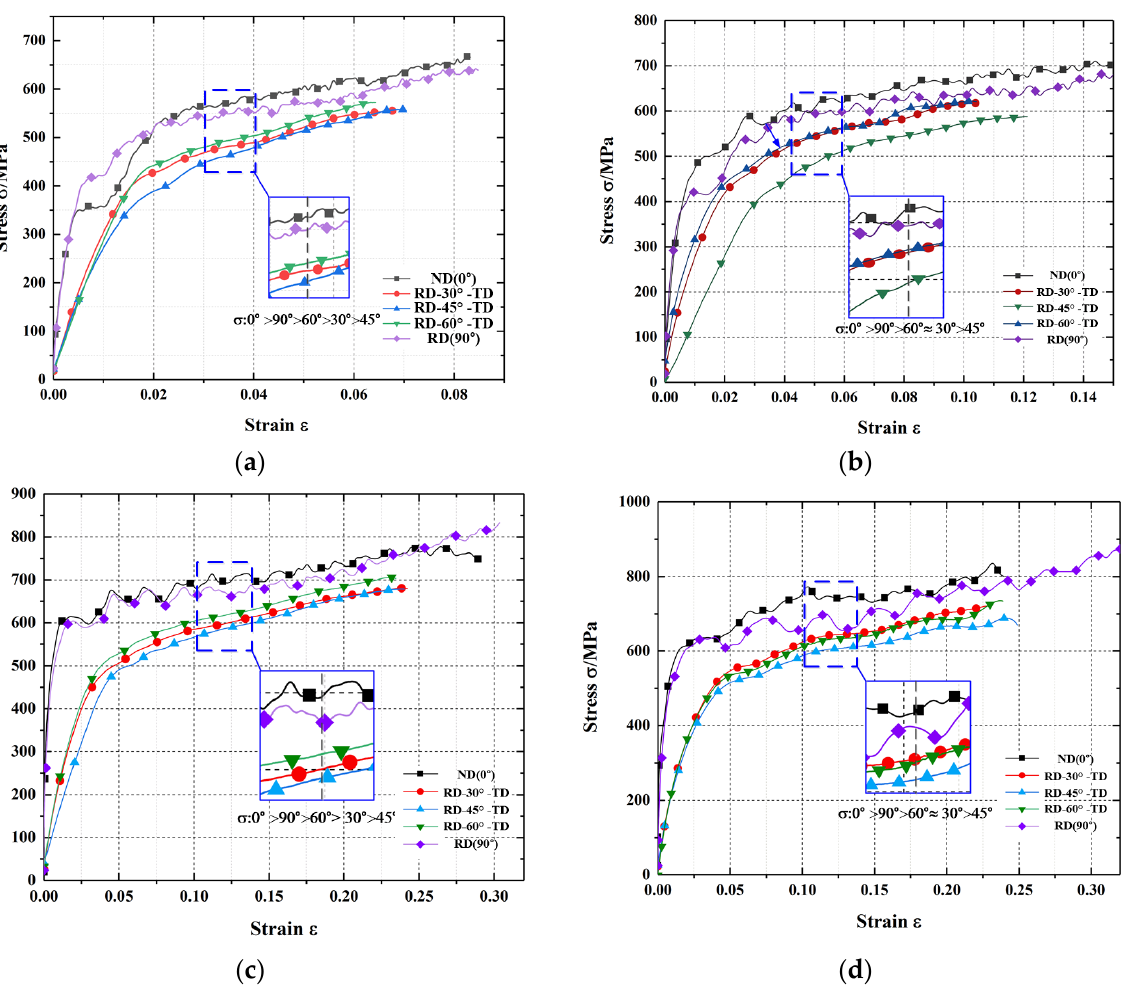
Figure 6. Stress–strain curves of AA7050-T7451 in different directions. ( a ) 0.1 × 10 4 s − 1 ; ( b ) 0.2 × 10 4 s − 1 ; ( c ) 0.4 × 10 4 s − 1 ; ( d ) 0.6 × 10 4 s − 1 .